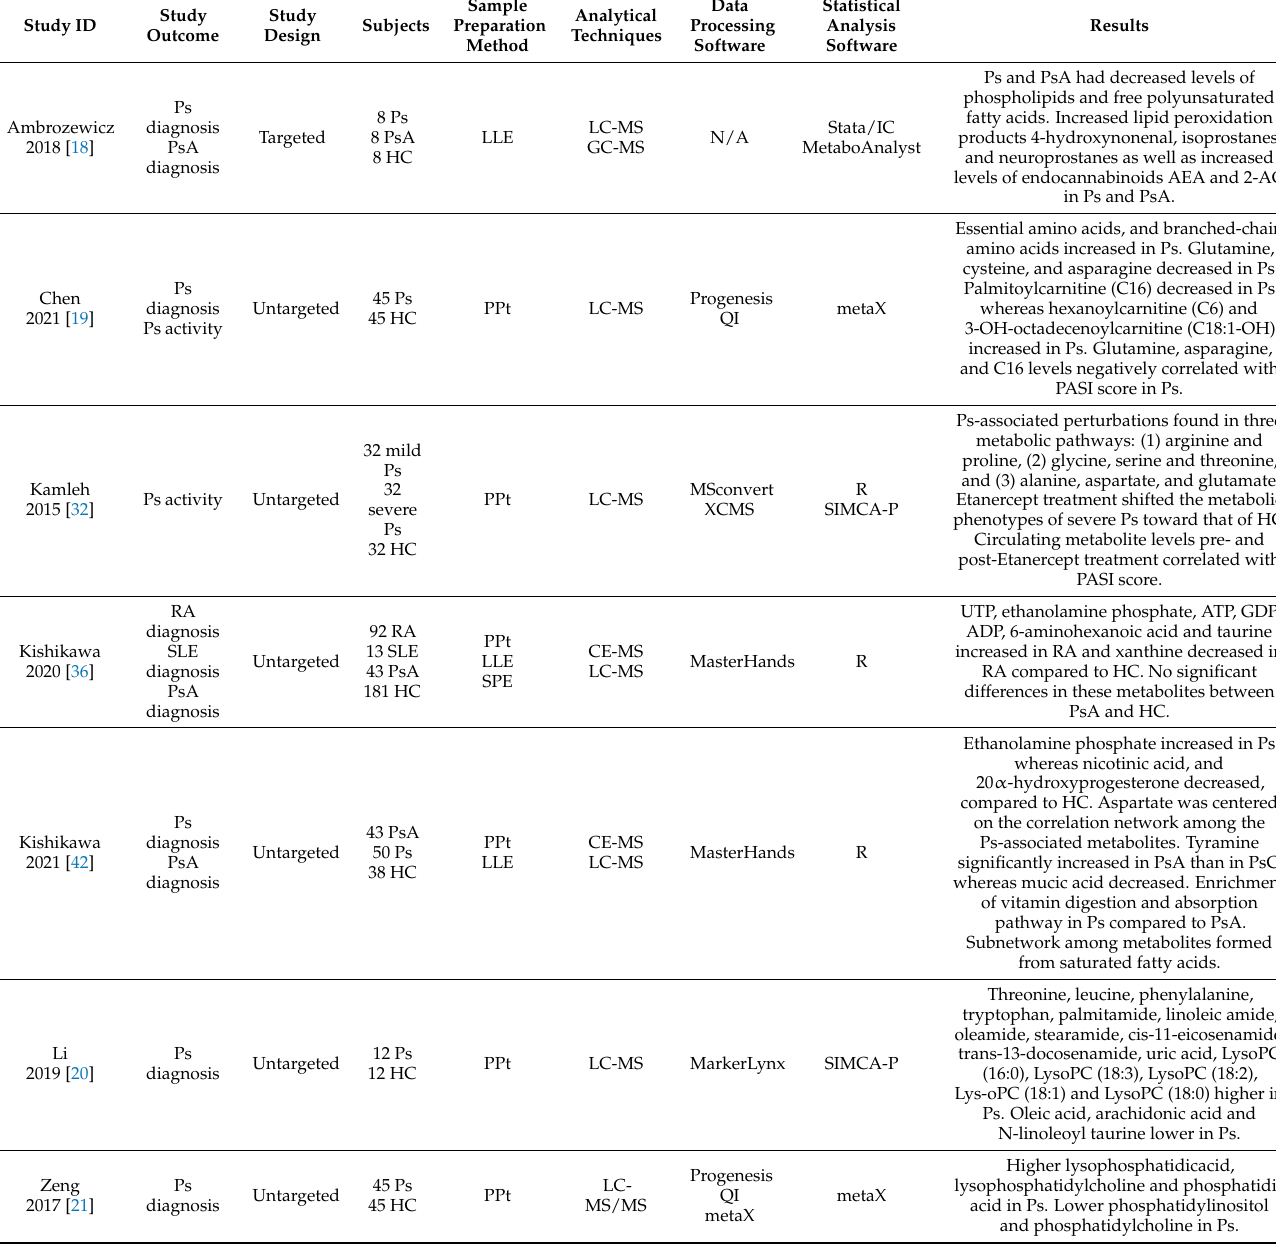
Table 3. Studies in